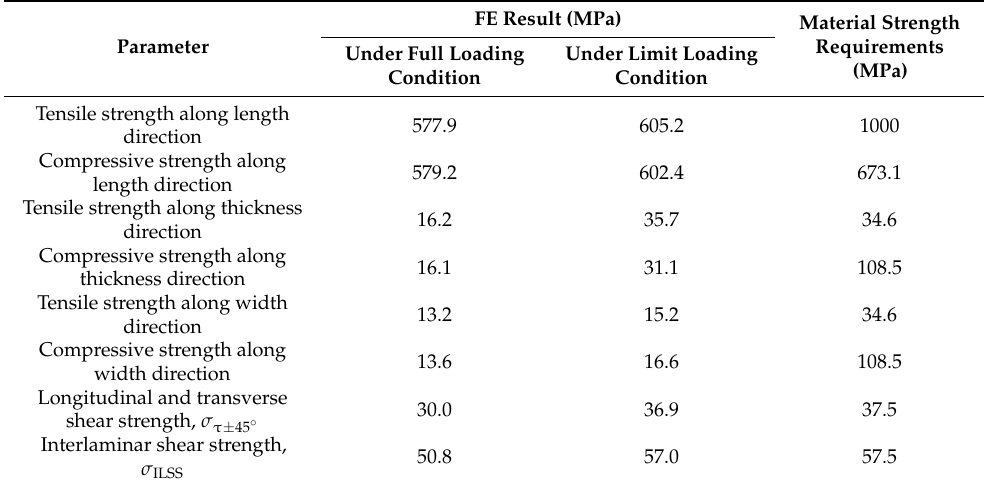
Table 5. Comparison between the finite element (FE) results of the composite leaf spring under full and limit loading conditions and the material strength